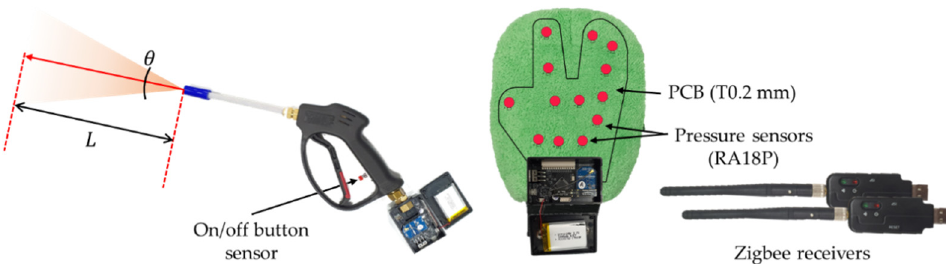
Figure 14. Training tools: Steam gun ( L : distance, θ : direction) with a button sensor, mob with pressure sensors, and data transmitters for sensor connection.